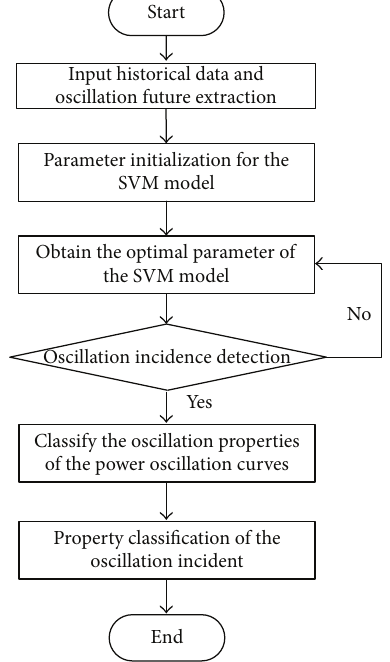
Figure 4: Flow chart of the oscillation property